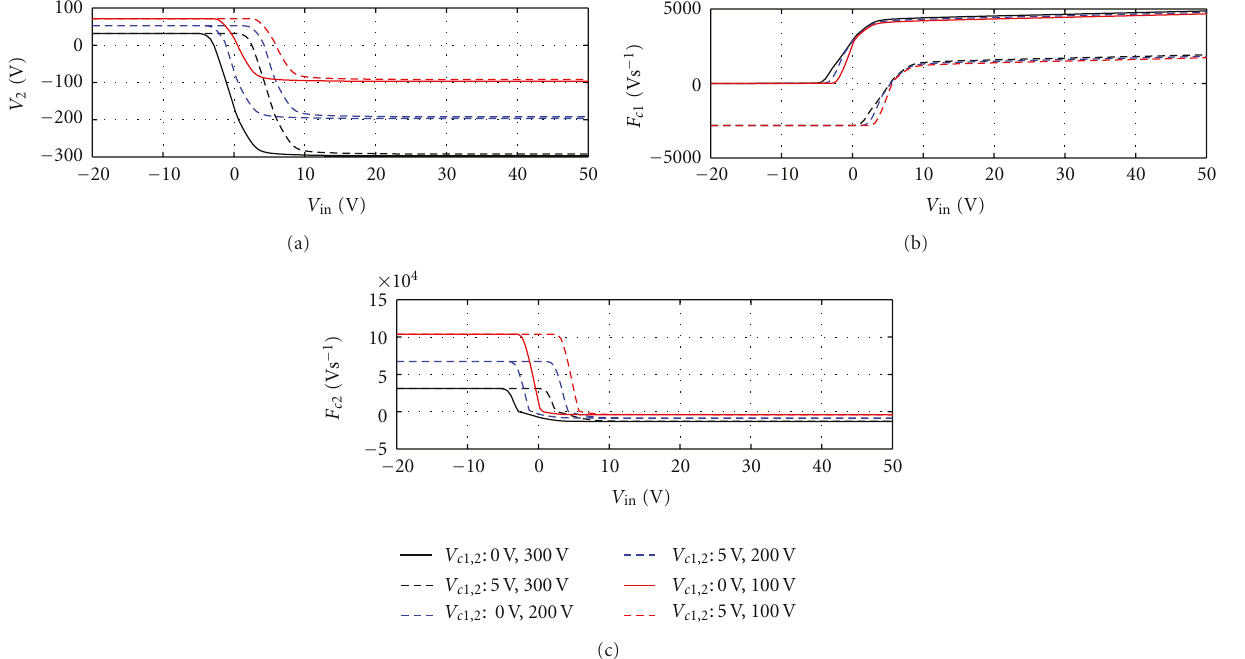
the Newton method was 1 × 10 − 5 . The number of iteration was computed from the whole signal (5 s, 240 × 10 3